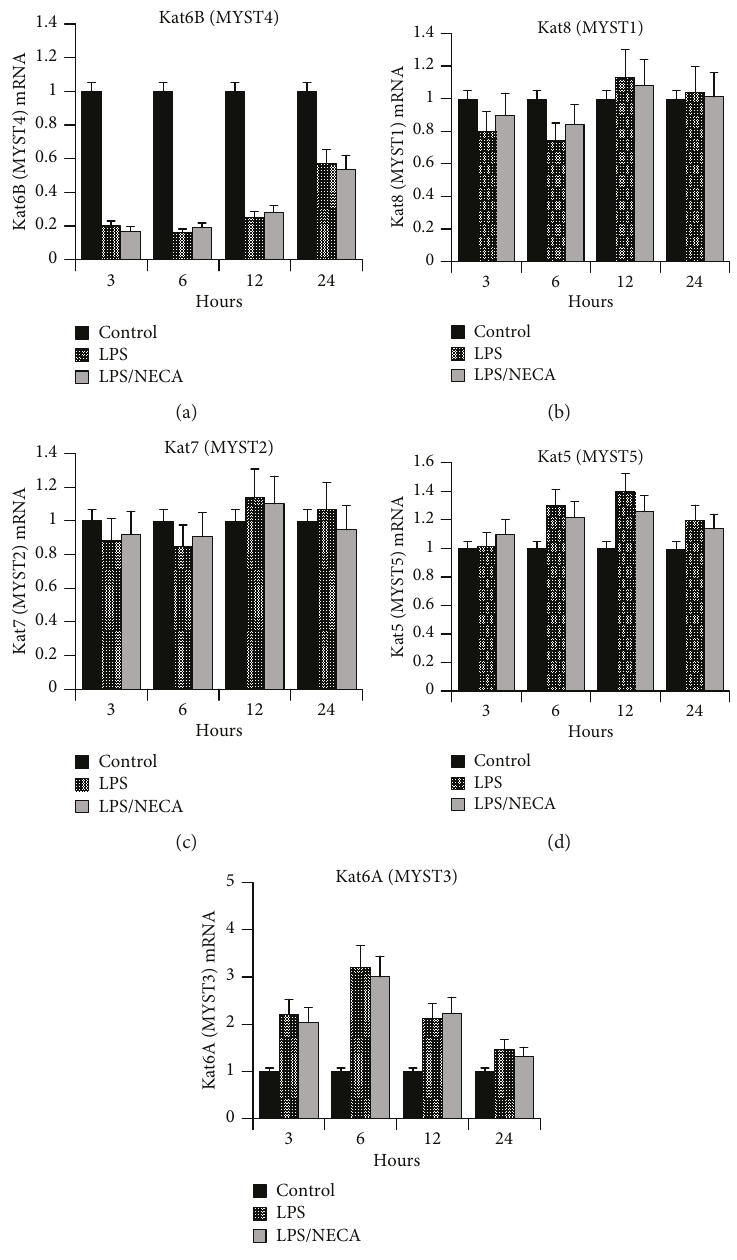
Figure 3: The expression of MYST family HATs (Kat6B, Kat6A, Kat5, Kat7, and Kat8) was determined using TaqMan Q-RT-PCR assays, with RNA samples from untreated macrophages or macrophages treated with LPS (100ng/ml), NECA (1 μ M), or LPS (100ng/ml) with NECA (1 μ M) for 3, 6, 12, and 24 hours. Data indicate mean fold change relative to untreated macrophages ± SE . Expression levels were normalized to that of cyclophilin-D as a housekeeping